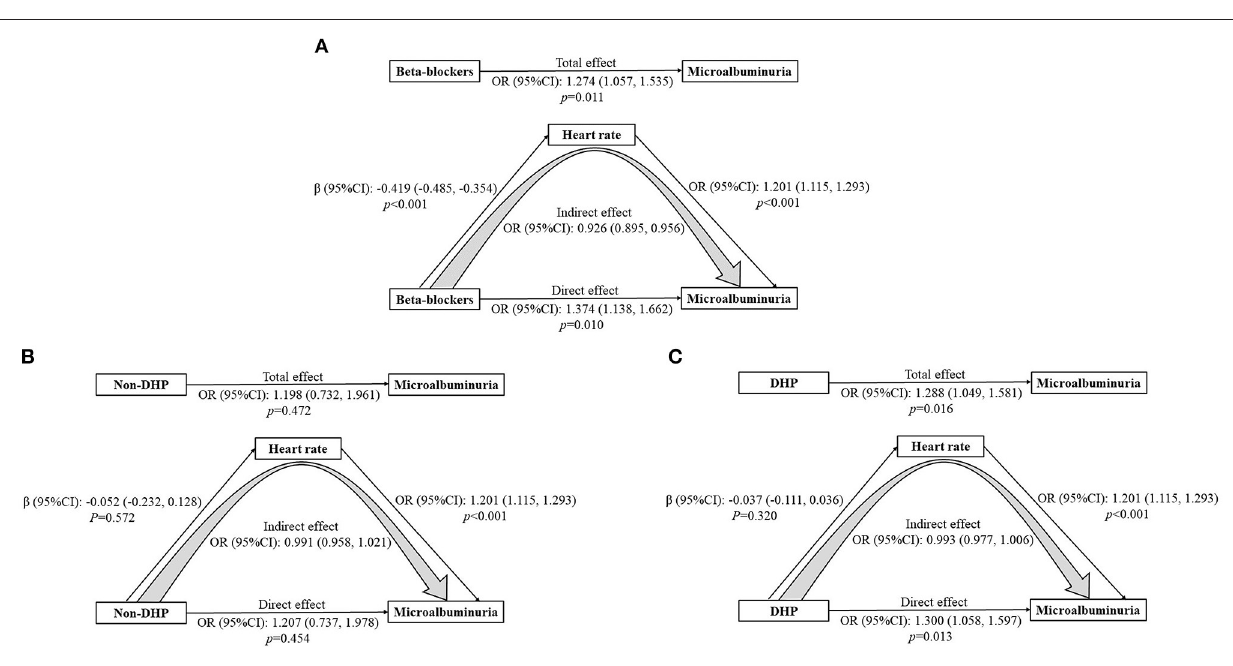
FIGURE 4 | (A-C) Mediation analysis of heart rate on the association between β -blockers/non-DHP and microalbuminuria. Adjusted for age, sex, body mass index, poverty income ratio, systolic blood pressure, total protein, estimated glomerular filtration rate, diabetes, and calcium channel blockers. CI, Confidence interval; OR, Odds